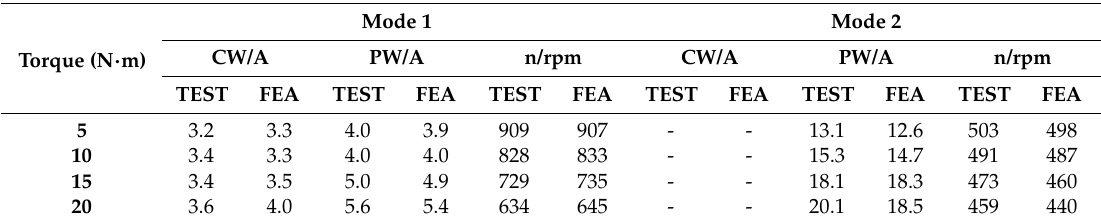
Table 2. Comparison of the current and speed of the prototype with the load. TEST: The results of the test; FEA: The results of the FEA; PW: Power winding; CW: Control winding.